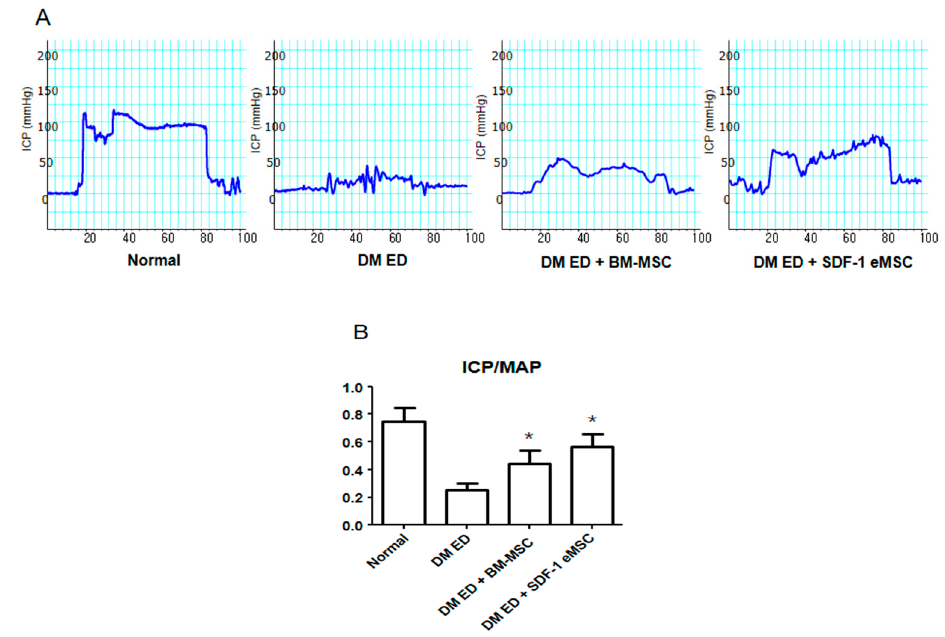
Figure 1. Comparison of erectile function among groups. ( A ) Representative images of intracavernous pressure (ICP) in response to electrical stimulation of the cavernosal nerve. ( B ) Ratio of ICP to mean MAP (mean arterial pressure) in each group. Each bar shows the mean value (standard deviation). * p < 0.05 compared with the DM ED (diabetes mellitus erectile dysfunction) group.